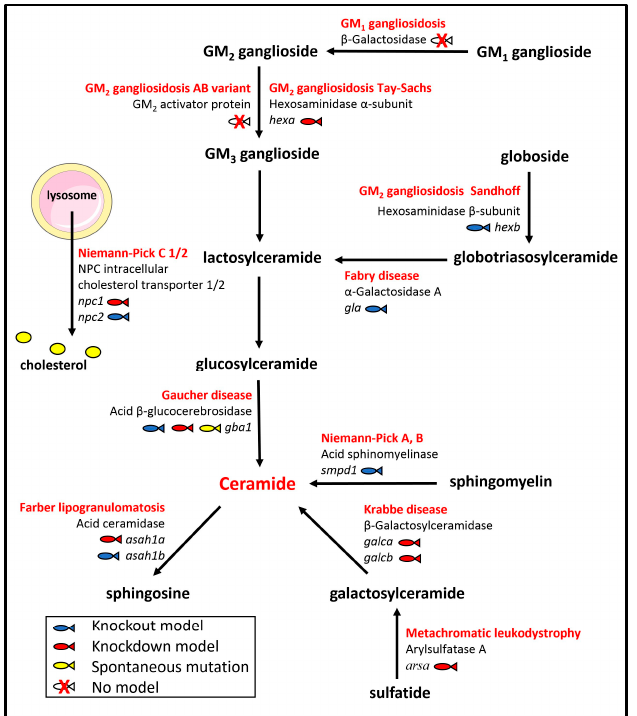
Figure 2. Sphingolipid catabolism. Schematic representation of the biochemical pathways of the sphingolipid catabolism related to hereditary human sphingolipidoses and corresponding non- functional enzymes. Zebrafish genes that have been knocked out or knocked down to generate models of sphingolipidoses are in italics. See text for